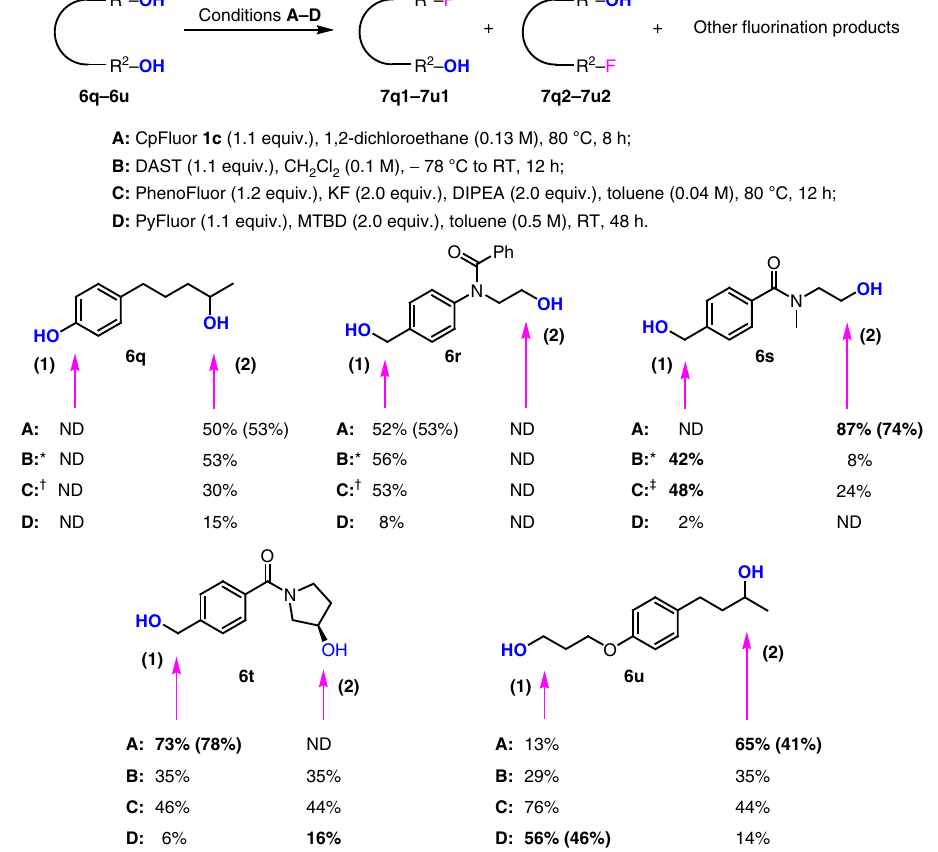
Figure 4 | Selective deoxyfluorination of longer diols. Selective deoxyfluorination of longer diols, where the two hydroxyl groups are separated by several carbon centers. The total fluorination yields at the given position were determined by 19 F NMR spectroscopy using PhCF 3 as an internal standard. The yields in parentheses refer to isolated yields of the monofluorination products with the retention of the other hydroxyl group. *1.5 equiv. of DASTwas used. w 1.5 equiv. of PhenoFluor was used. z The reaction was performed using 1.0 equiv. of PhenoFluor at RT for 48h. DIPEA, N , N -diisopropylethylamine;